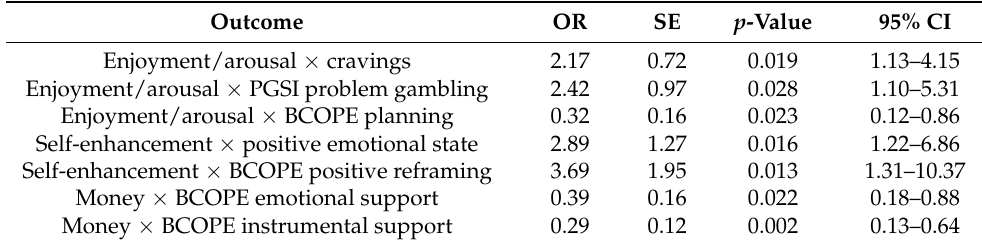
Table 5. Moderated regression analyses of the relationships between EMA gambling outcome expectances and gambling episodes a